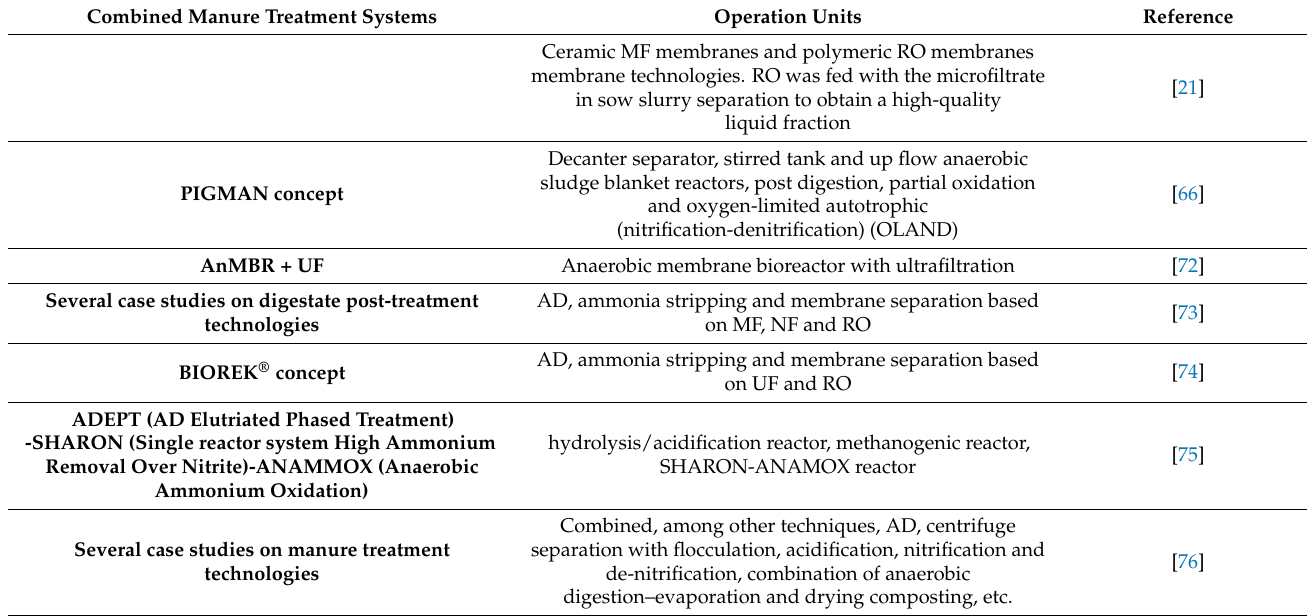
Figure 1. Post-treatment of digestate manure after solid liquid separation using screw press and different membrane technologies. Table 2 gathers some essential literature about different manure treatment processes. Table 2. Combined manure treatment